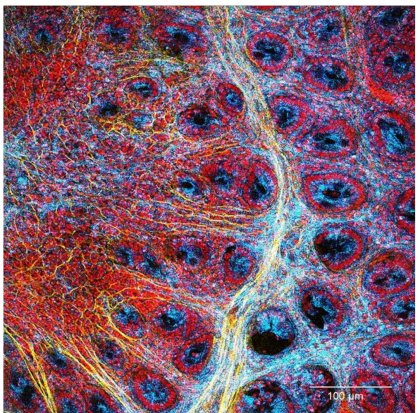
Figure 1. Lymphatic follicle in the colon mucosa at one month after the end of DSS colitis induction. The collagen structure surrounding the follicle (yellow) appears thickened. Increased signal of the connective tissue is present also in the inter-cryptal spaces (lower right in the figure, light blue and yellow colours). Merging of Draq5 nuclear staining (red, confocal microscopy), mucosa (blue, reflectance confocal microscopy—RCM), and collagen (yellow, second harmonic generation—SHG by multi-photon confocal microscopy); objective HC PLAPO 20 × /0.70 lMM CS with water